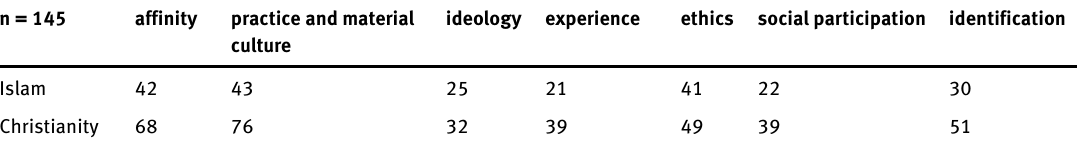
Table 10. Frequency of modalities in the group Christianity – Islam n = 145 affinity practice and material